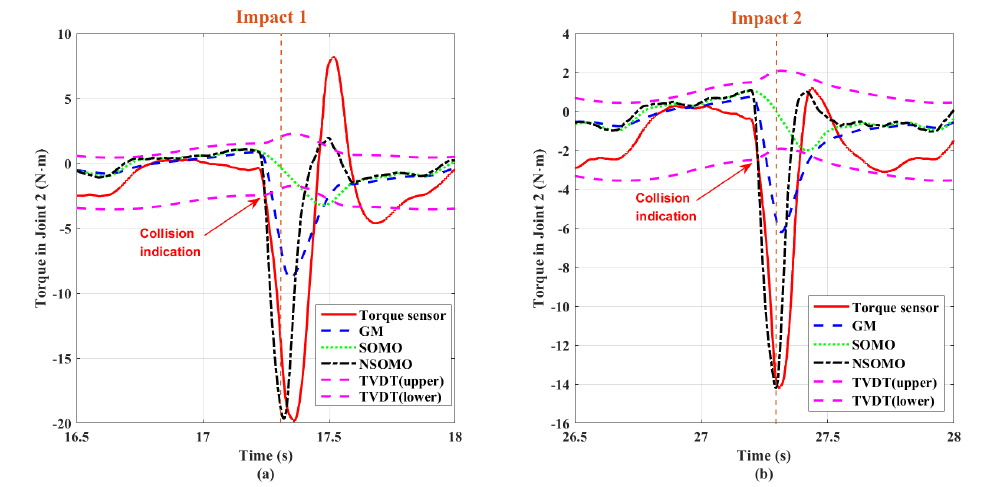
Figure 12. Comparison of dynamic collision torque estimations for Joint 2: GM, SOMO, NSOMO and torque sensor; ( a ) first collision; ( b ) second collision.